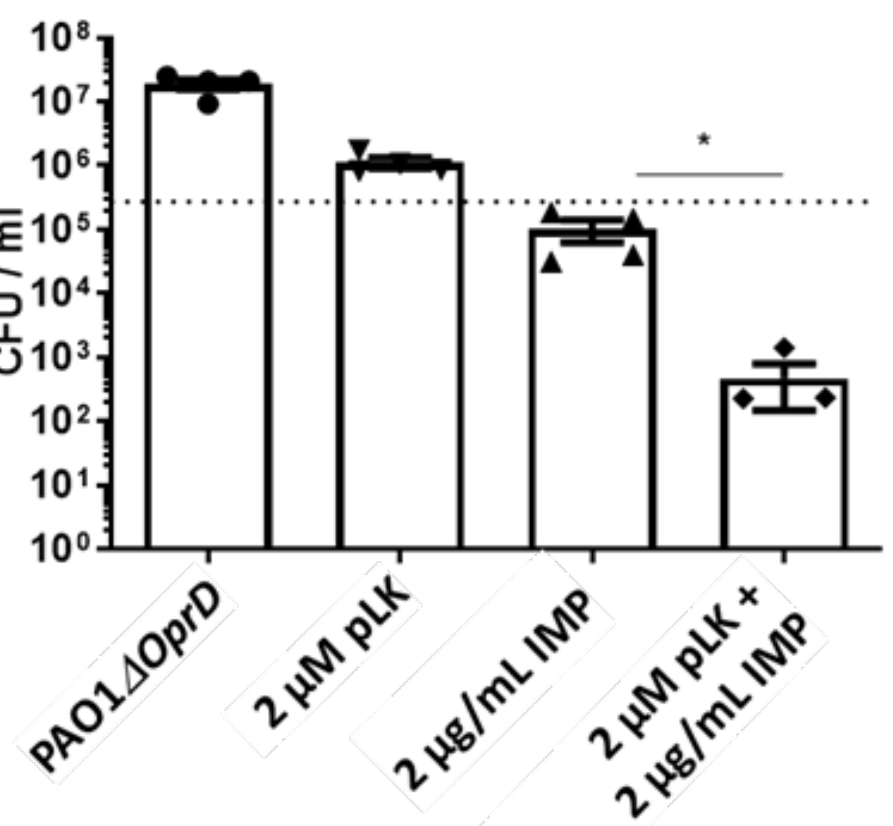
Figure 4. Ex vivo synergistic effect of the association between pLK and imipenem against an imipenem-resistant P. aeruginosa strain. Human primary bronchial epithelial cells maintained in an air–liquid interface were infected with PAO1 ∆ OprD strain and treated one hour postinfection with either PBS, 2 µ M pLK, 2 µ g/mL imipenem or with a combination of the two molecules. Determination of the colony forming unit (CFU)/mL was evaluated 24 h postinfection. Values are mean ± SEM of three independent experiments. Statistical analysis was performed using the Mann – Whitney test (* p < 0.05).